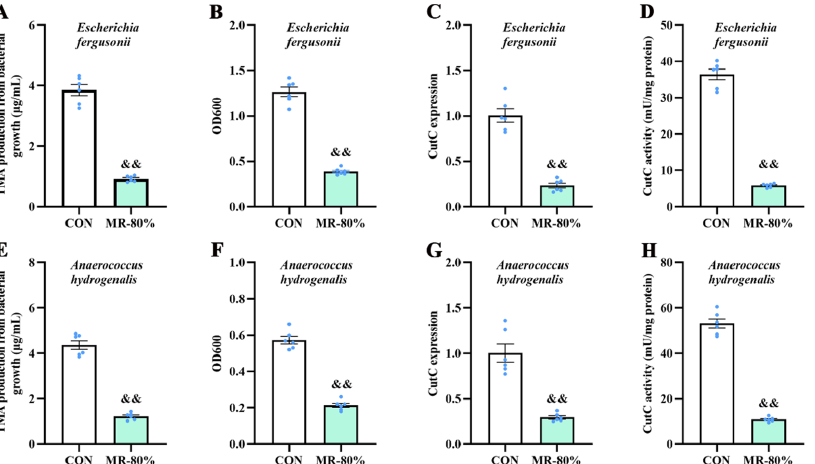
Figure 6. Effects of MR on TMA production ( A , E ), bacteria abundance ( B , F ), and CutC expression ( C , G ) and activity ( D , H ) in Escherichia fergusonii ATCC 35,469 and Anaerococcus hydrogenalis DSM 7454 cultured anaerobically in medium. MR, methionine restriction; TMA, trimethylamine; CutC, choline trimethylamine-lyase; CON, normal diet group; MR-80%, 0.17% methionine. && p < 0.01 (MR-80% vs. CON).